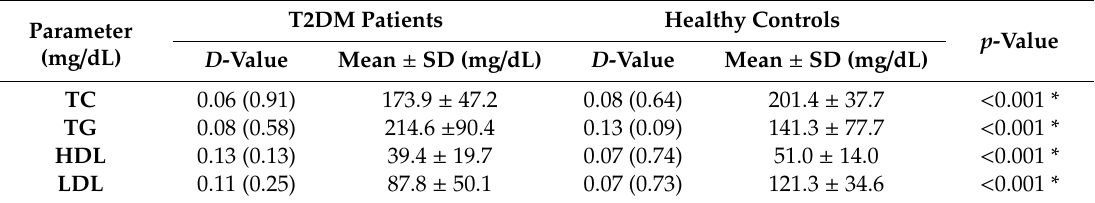
Table 5. Lipid profile analysis in T2DM patients ( n = 82) and healthy controls ( n = 82). Parameter (mg /